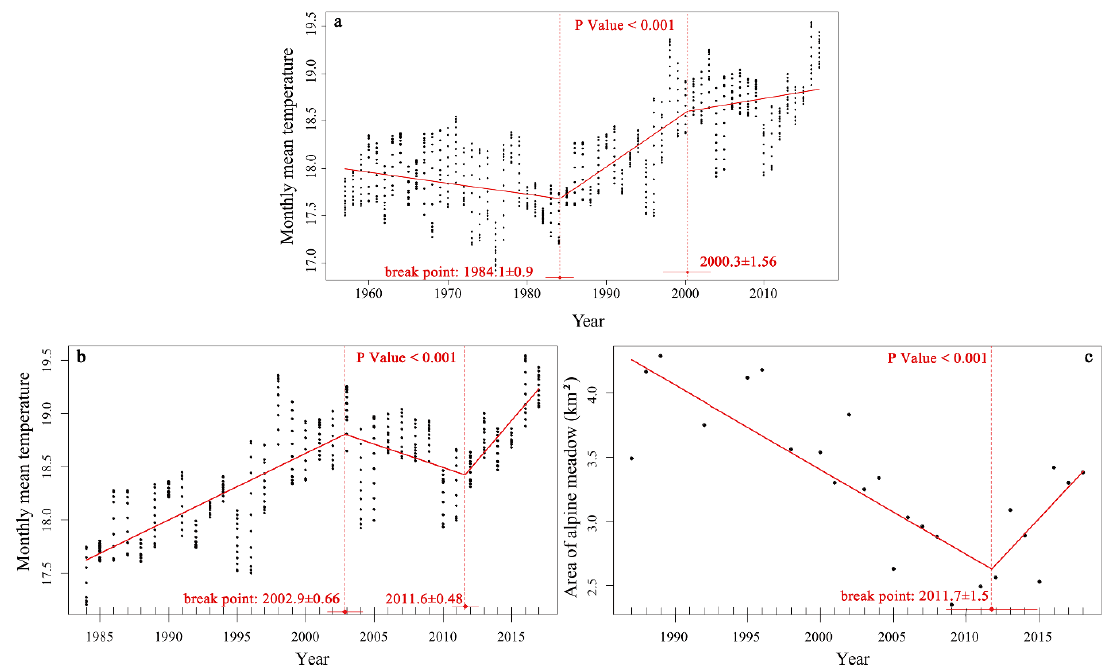
Figure 9. ( a ) Temporal trend of monthly mean temperature in the study area from 1957 to 2017 (seasonal variation was removed from temperature data using time-series analysis in the R software), ( b ) temporal trend of monthly mean temperature in the study area from 1984 to 2017 (seasonal variation was removed from temperature data using time-series analysis in the R software), and ( c ) temporal trend of the area extracted for the alpine meadow using the LISA concept.